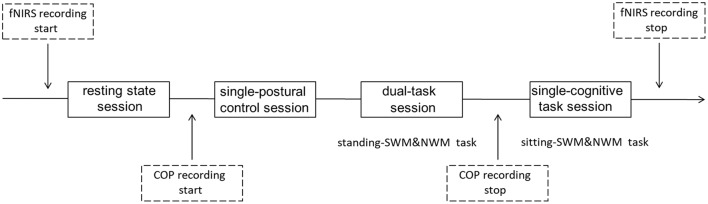
Schema of current design. All subjects had a resting state session for ~65 s at the beginning of the testing period. Then, half of the subjects had a single-postural control session before the dual-task and single-cognitive task sessions, while others completed the single-postural control session last; the session type order was counterbalanced across subjects. Different WM tasks were also counterbalanced within subjects. Each WM-related task had two 65-s blocks. fNIRS data were collected throughout all sessions. Center of pressure (COP) data were recorded during the single-postural control and dual-task sessions.